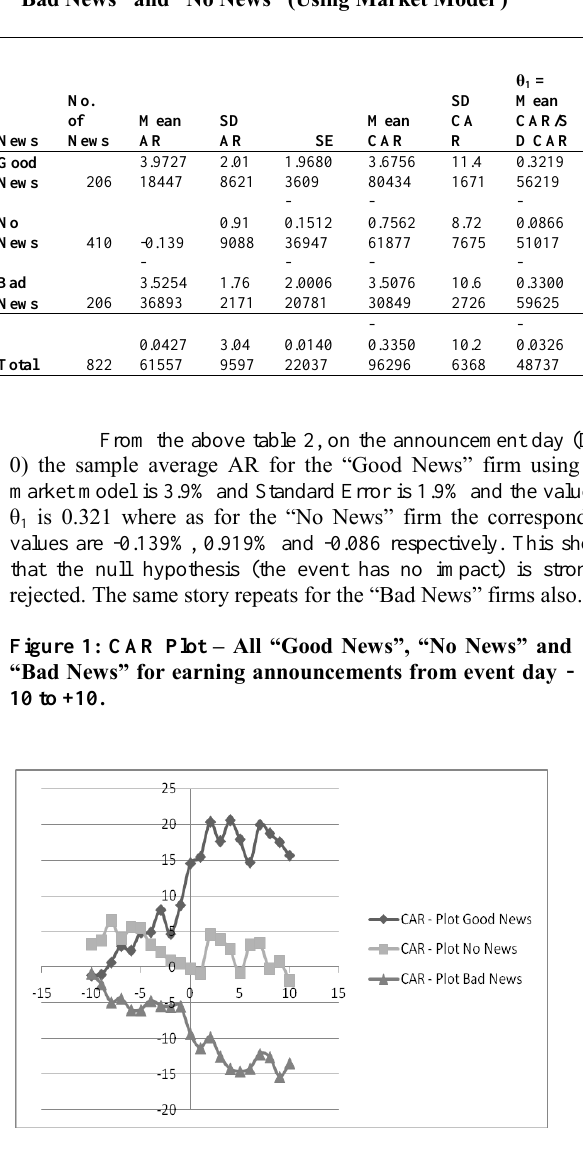
Table 2 : Mean and SD of AR and CAR for “Good News”,